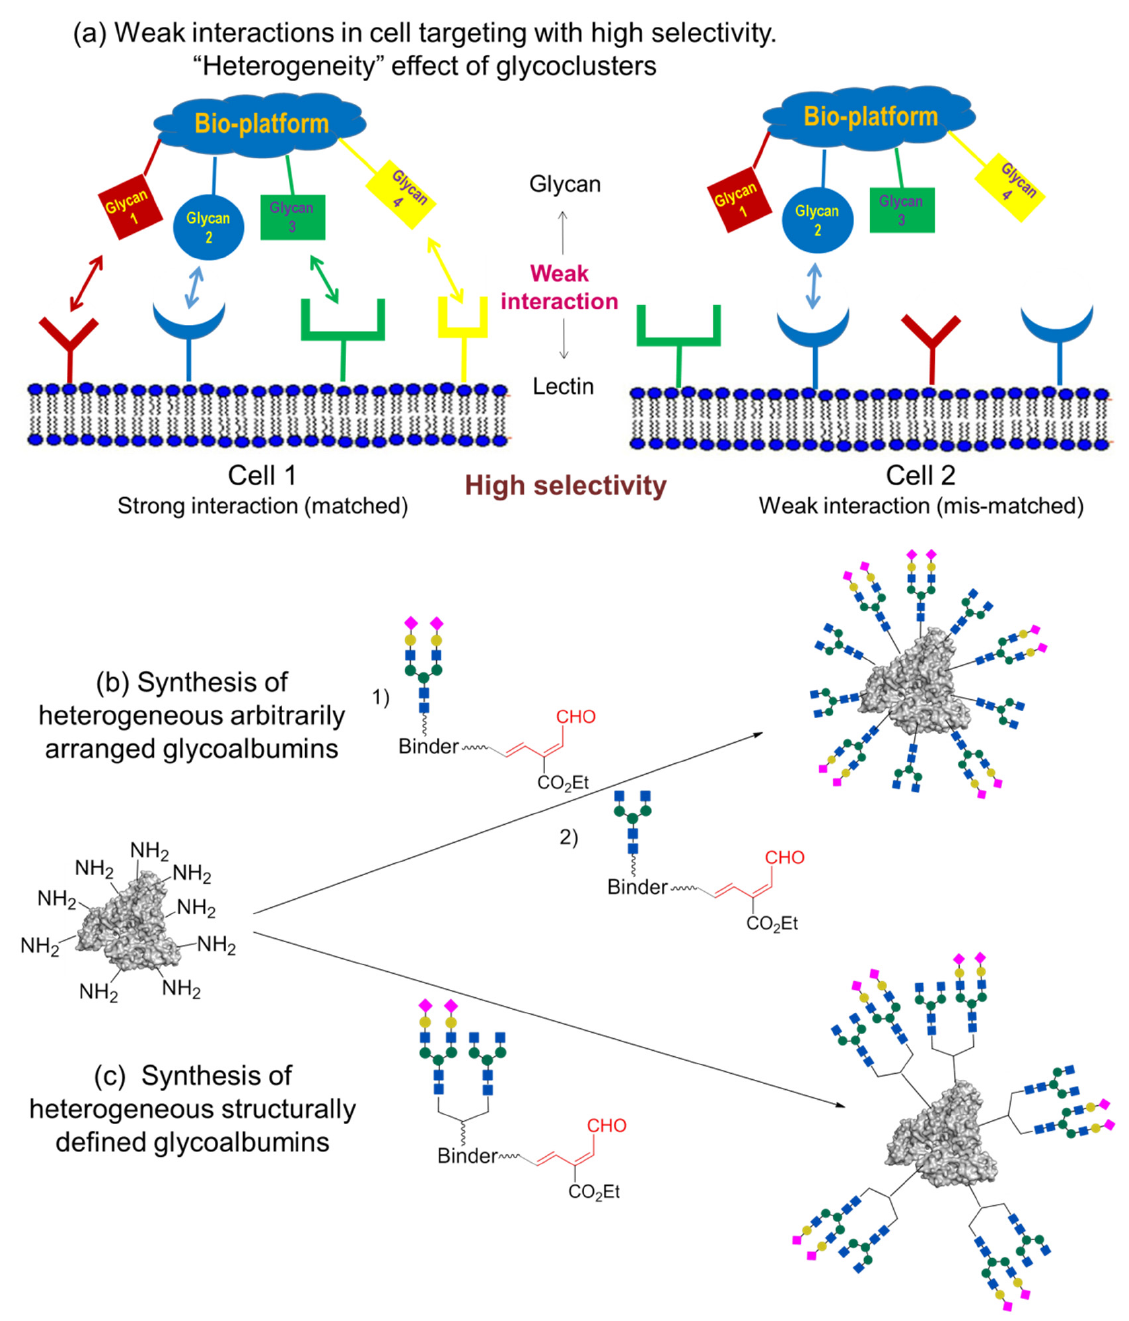
Figure 5. ( a ) Selective and strong interaction of heterogeneous glycoconjugates with target cells through pattern recognition using effect of heterogeneity. Glycans and lectins of the same shape and color interact with each other. Bio-platform: cell, antibody, protein, etc. Synthesis of two types of heterogeneous N -glycoalbumins containing two different N -glycan fragments—( b ) arbitrarily arranged glycoalbumins and ( c ) structurally defined glycoalbumins [44]. Copyright Wiley-VCH GmbH. Reproduced with permission.